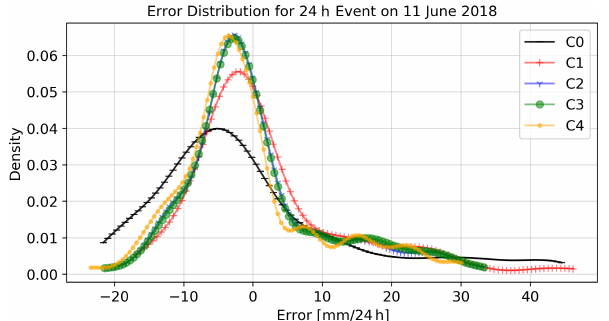
Figure 14. Distribution of the cross validation errors for the 24h event from 00:00 to 24:00LT on 28 July 2018, for the five inter- polation methods. C0 – using primary stations only and OK; C1 – primary and all secondary, without filter and OK; C2 – primary and secondary, using IBF and OK; C3 – primary and secondary, us- ing IBF, EBF and OK; C4 – primary and secondary, using IBF, EBF and